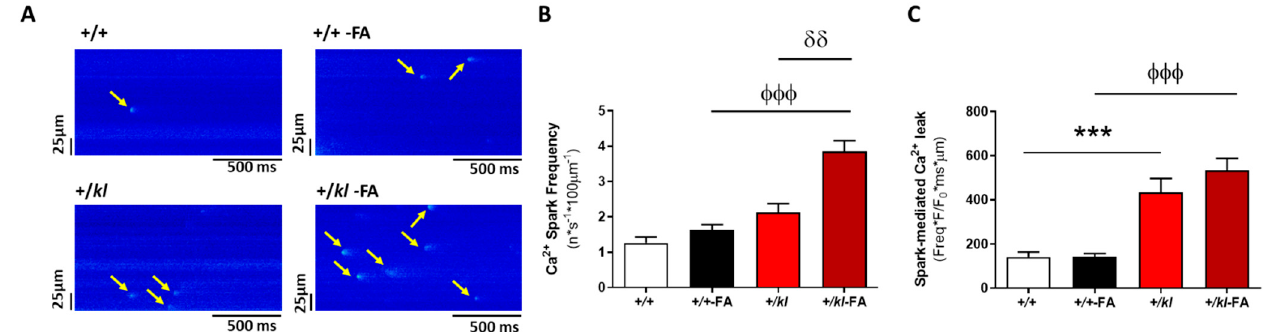
Figure 4. Partial klotho deficiency increases the frequency of diastolic Ca 2+ leak in cardiomyocytes after AKI four times. ( A ) Representative line-scan images of Ca 2+ sparks in quiescent cardiomyocytes from +/+, +/+-FA, +/ kl and +/ kl -FA mice. The arrows point to the released Ca 2+ sparks in each repre- sentative image. ( B ) Frequency of Ca 2+ sparks (presented in n·s − 1 ·100 µm − 1 ) in cardiomyocytes from +/+ (n = 49 cells, N = 5 mice), +/+-FA (n = 75 cells, N = 4 mice), +/ kl (n = 48 cells, N = 5 mice) and +/ kl - FA mice (n = 57 cells, N = 3 mice). ( C ) Spark-mediated Ca 2+ leak: frequency × amplitude (F/F0) × duration (ms) × width (µm) of Ca 2+ sparks in cardiomyocytes from +/+ (n = 49 cells, N = 5 mice), +/+- FA (n = 75 cells, N = 4 mice), +/ kl (n = 48 cells, N = 5 mice) and +/ kl -FA mice (n = 57 cells, N = 3 mice). Data are expressed as mean ± SEM. *** p < 0.001 vs. +/+, ϕϕϕ p < 0.001 vs. +/+-FA, δδ p < 0.01 vs. +/ kl .